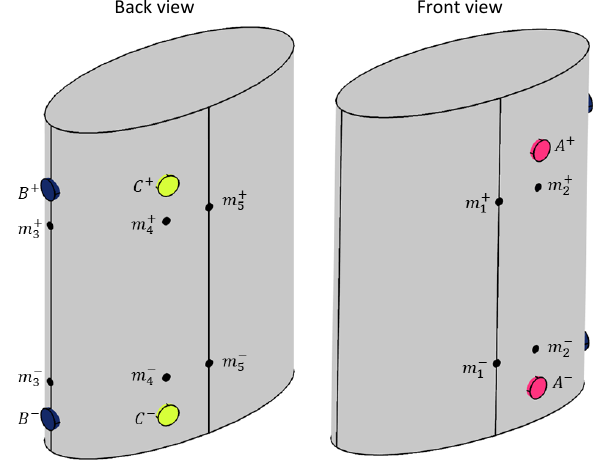
Fig.9: Source electrode pairs and measurement electrode pairs